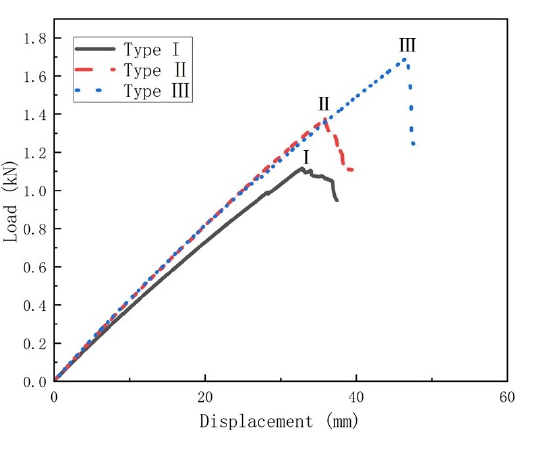
at 50 °C ( a ) Load–displacement curve for GFRP pipes; ( b ) Failure mode.